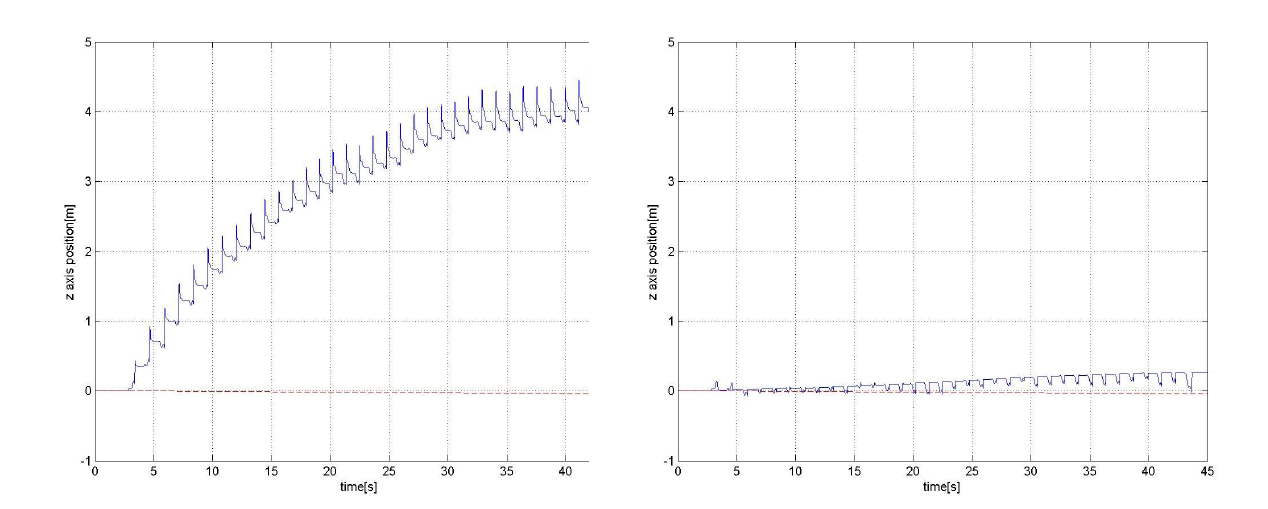
Figure 8. z axis position estimation for road A without (left) and with (right) the proposed height